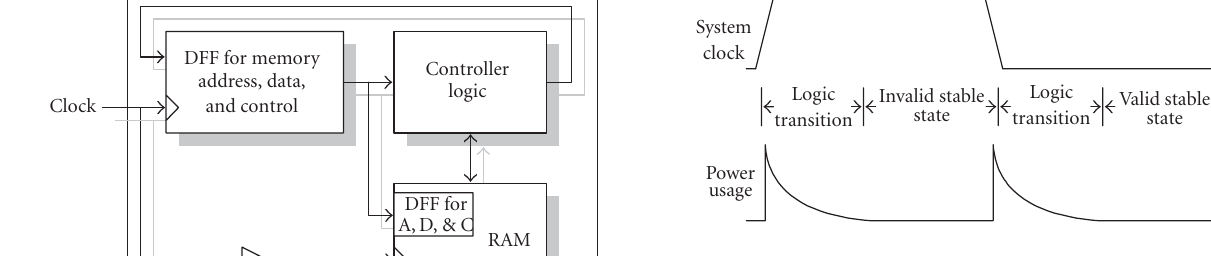
Figure 8: Two-phase clock power consumption.